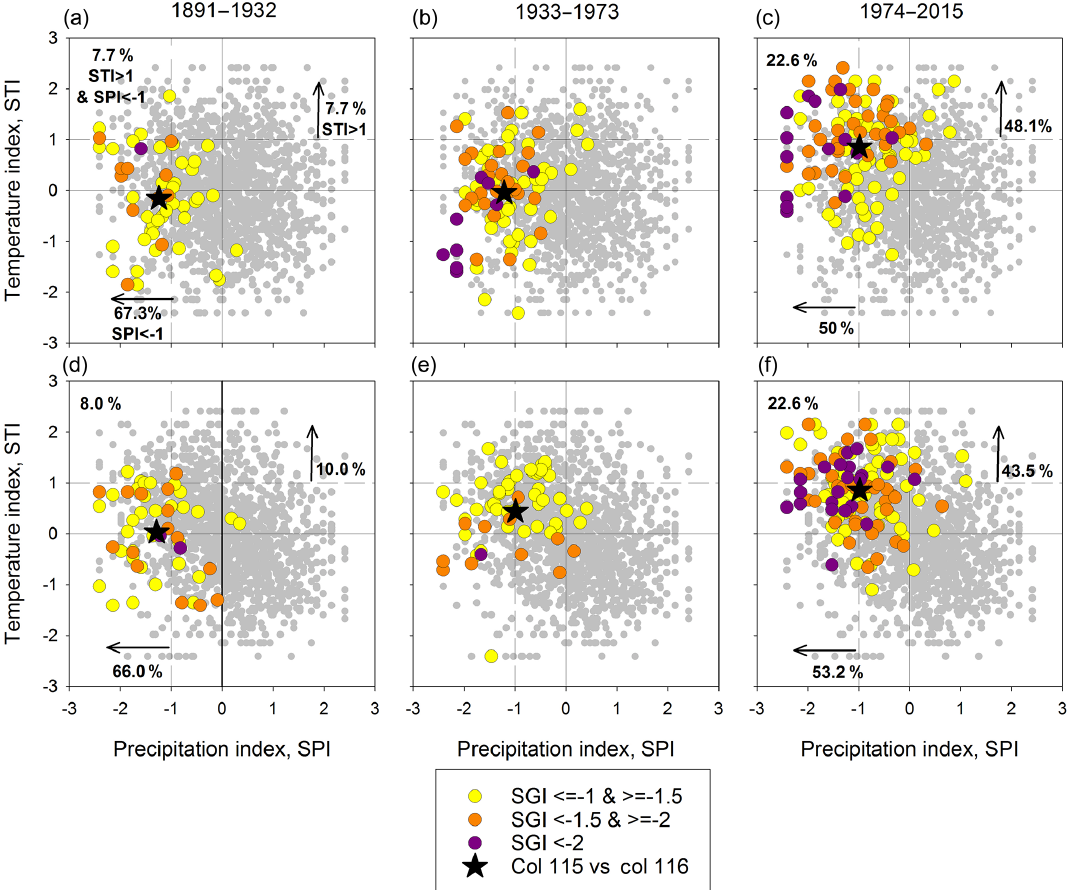
Figure 4. Occurrence of groundwater drought months as a function of SPI and STI at CH (a, b, c) and at DH (d, e, f) , for the periods 1890–1932, 1933–1973 and 1974–2015. For reference, all monthly values from 1891–2015 are shown as grey symbols and all months were SGI > − 1 for a given period are shown as open white circles. Black stars denote the centroid of the groundwater drought months for each of the three